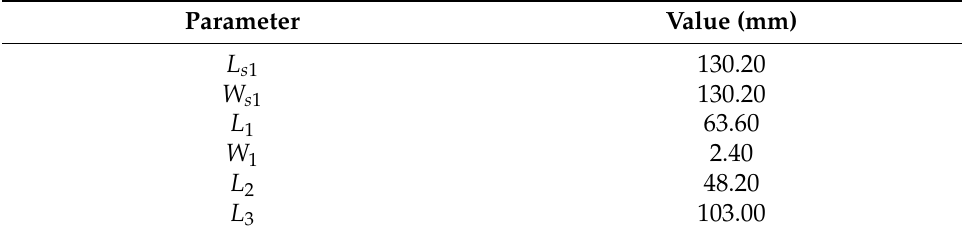
Figure 1. Iteration 1 design ( a ) Top view ( b ) side view. Table 1. Parameters of Iteration 1 design.